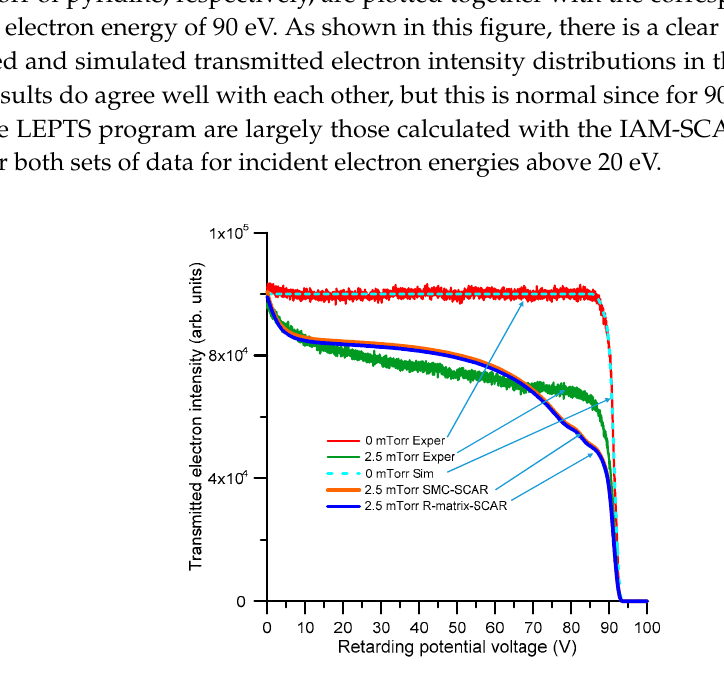
Figure 10. Transmitted electron intensity distribution (i.e., the intensity of the electrons with axial kinetic energy above the retarding potential barrier) through 0 and 2.5 mTorr of pyridine, respectively, but now for a 90 eV incident electron energy beam.